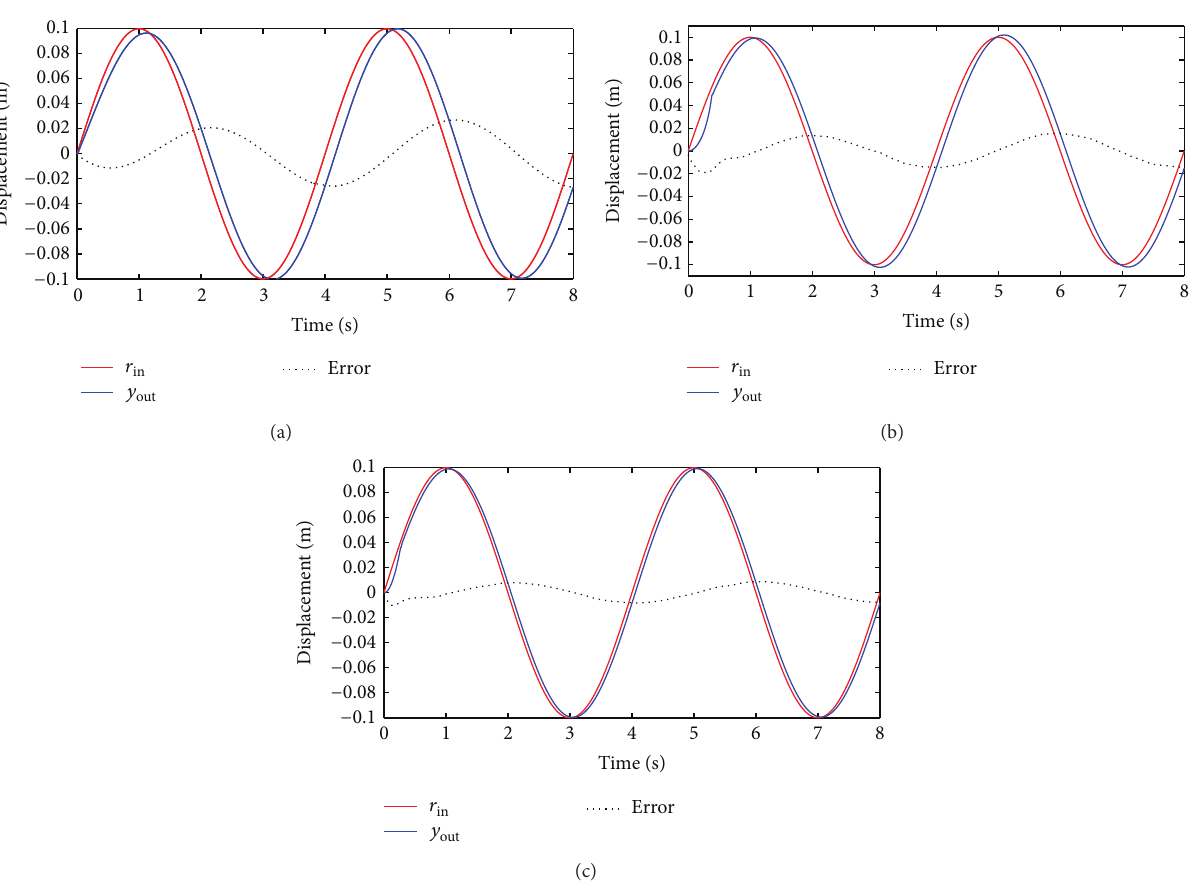
Figure 9: Experimental results for VCAHC of sine signal under fixed load: (a) PID controller, (b) CMAC-PID controller, and (c) CMAC- PI 𝜆 D 𝜇 controller.